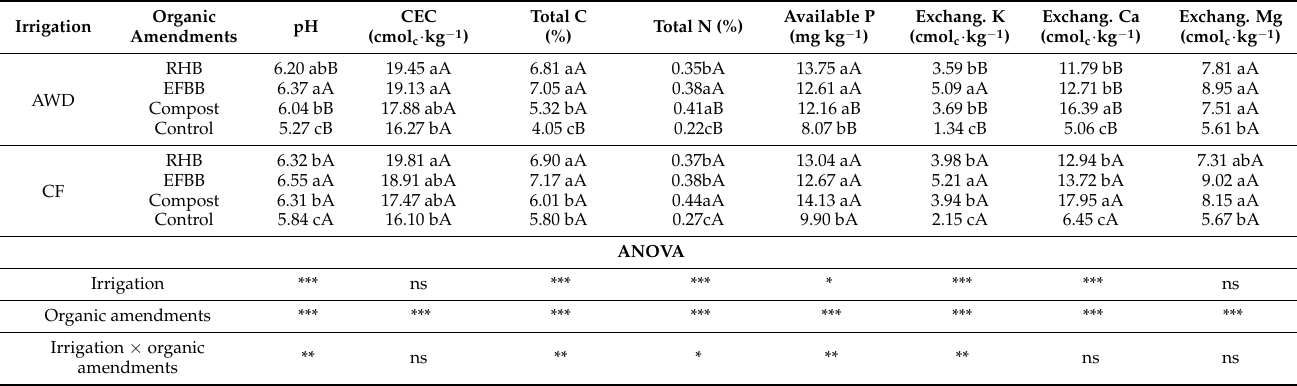
Table 5. Effects of organic amendments and irrigation management on chemical properties of the paddy soil at harvest. Irrigation Organic